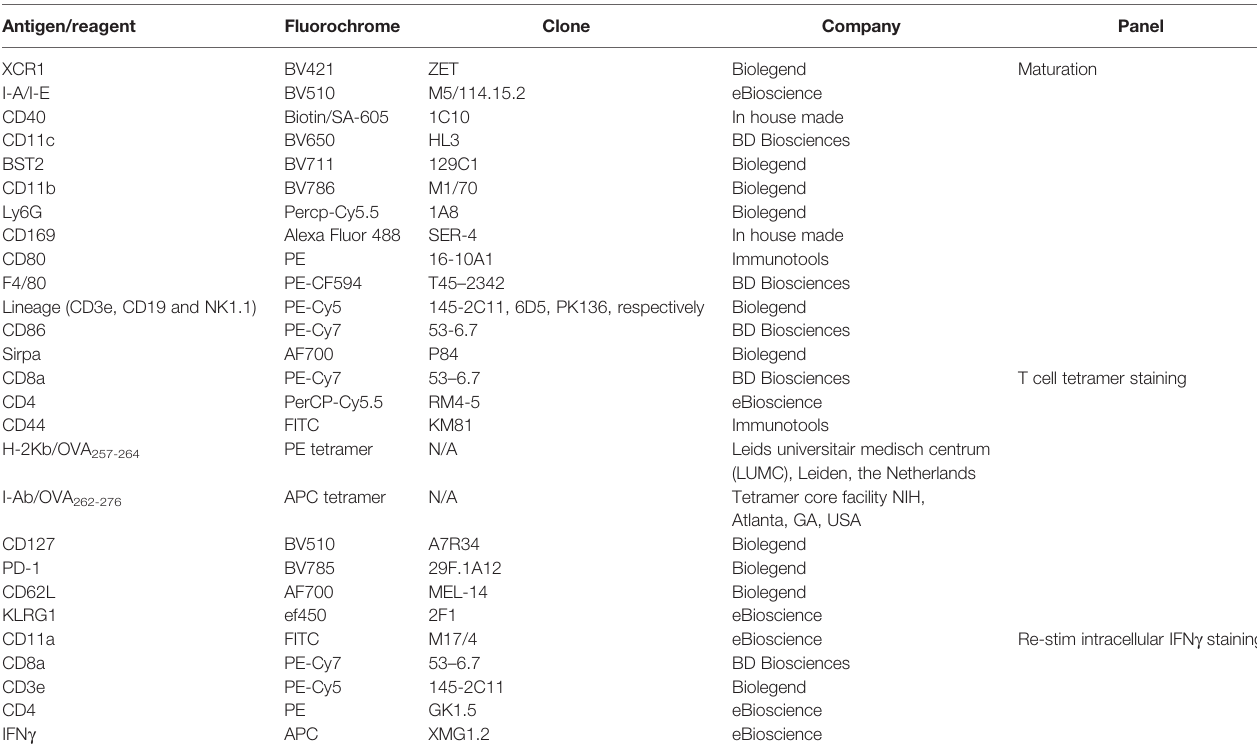
TABLE 1 | Anti-mouse